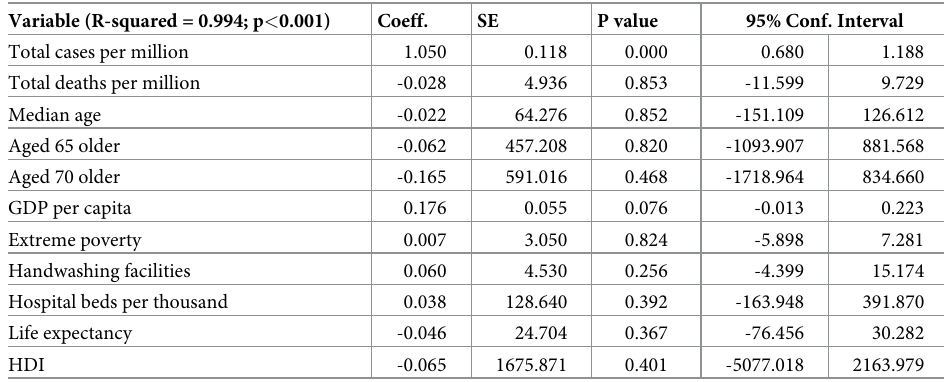
Table 4. Linear regression (multivariable) of total recoveries per million and predictor variables. Variable (R-squared = 0.994; p < 0.001)